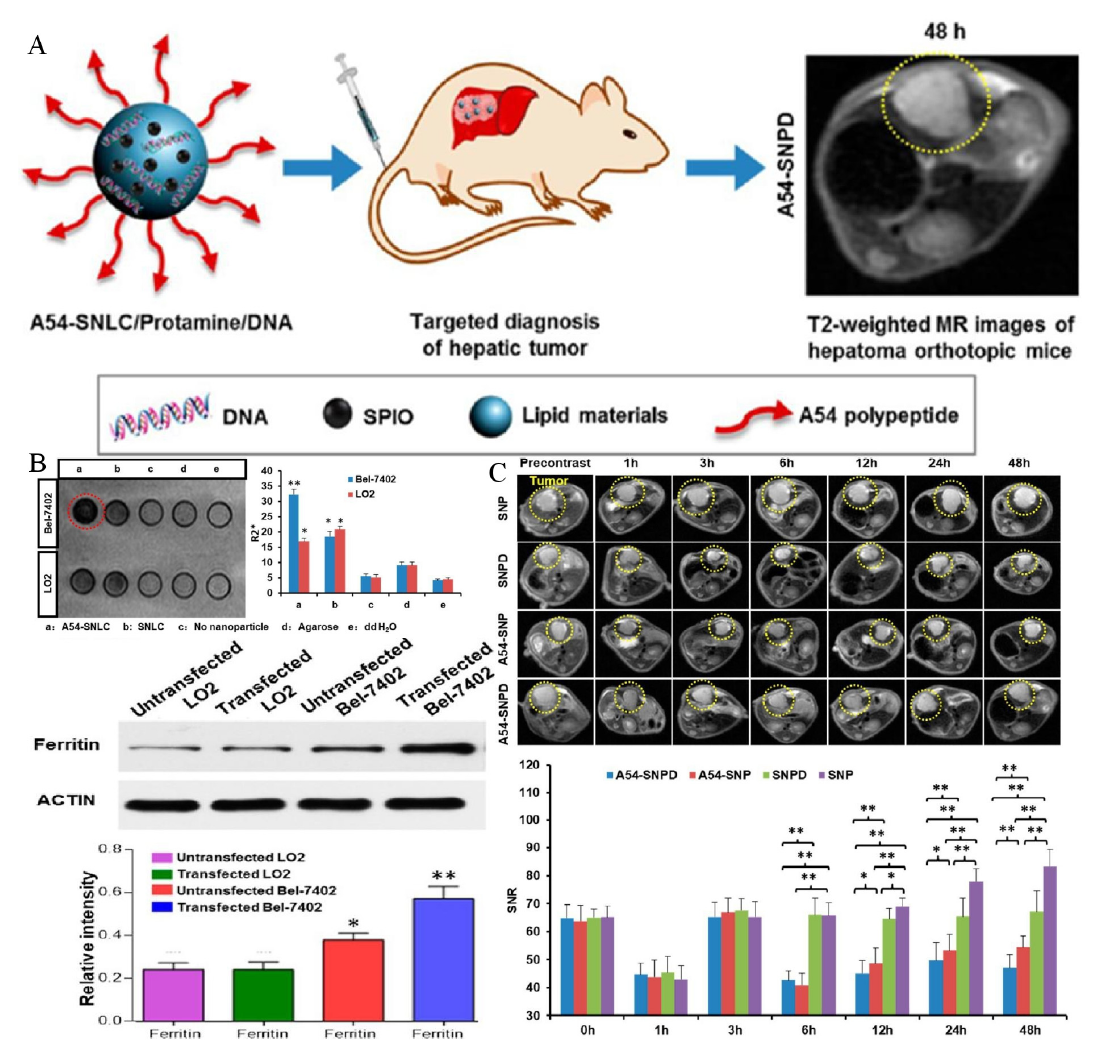
Figure 4. ( A ) A scheme to illustrate the structure of active dual-target nanostructured lipid carrier and the targeted imaging effect in HCC orthotopic mice. ( B ) Cells can specifically uptake the lipid carrier and increase the expression of intracellular ferritin. (**, p < 0.01, *, p < 0.05, compared with control group). ( C ) T2-weighted imaging of HCC orthotopic mice in vivo (**, p < 0.01, *, p < 0.05). Reproduced with permission Ref. [109]. Copyright 2017 American Chemical